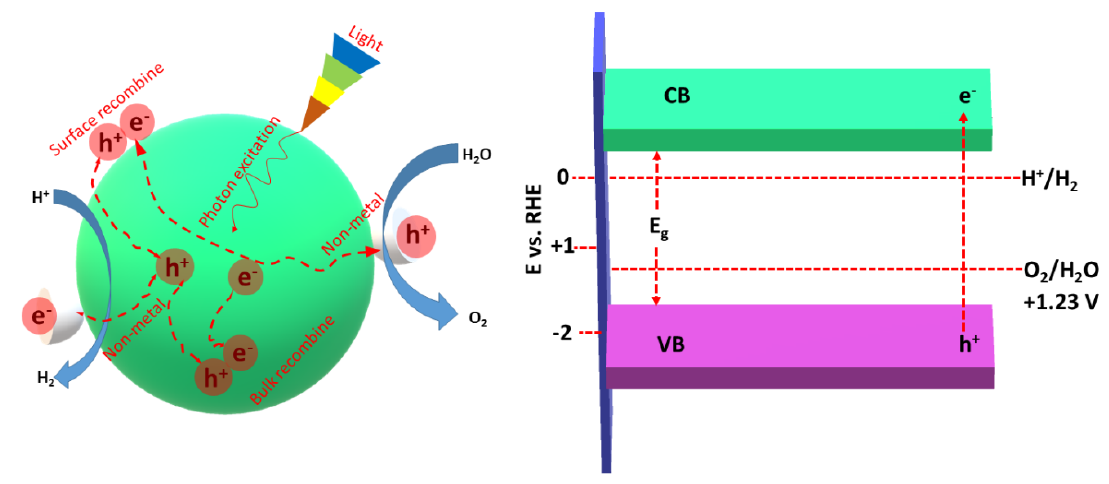
Figure 3. The role of non-metal dopants and the photocatalytic HER mechanism using non-metal doped porous gCN ( left ) and the band gap of gCNs relative to the required energy barrier for water splitting ( right ). This figure was designed based on the data in Ref [61].